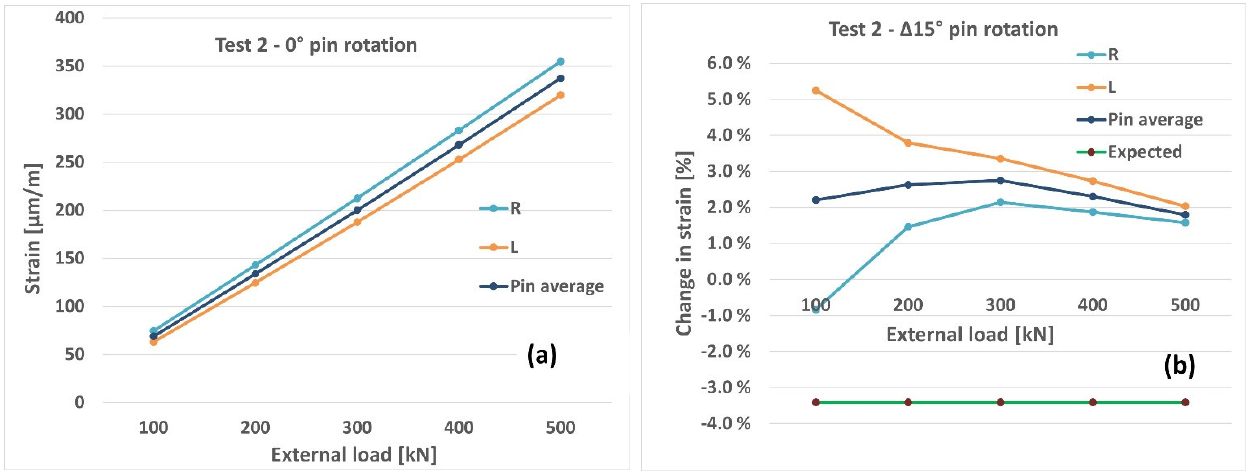
Figure 11. Test 3, ( a ) strains at 0° position, ( b ) percentage change of strains from 0° to 15° position.